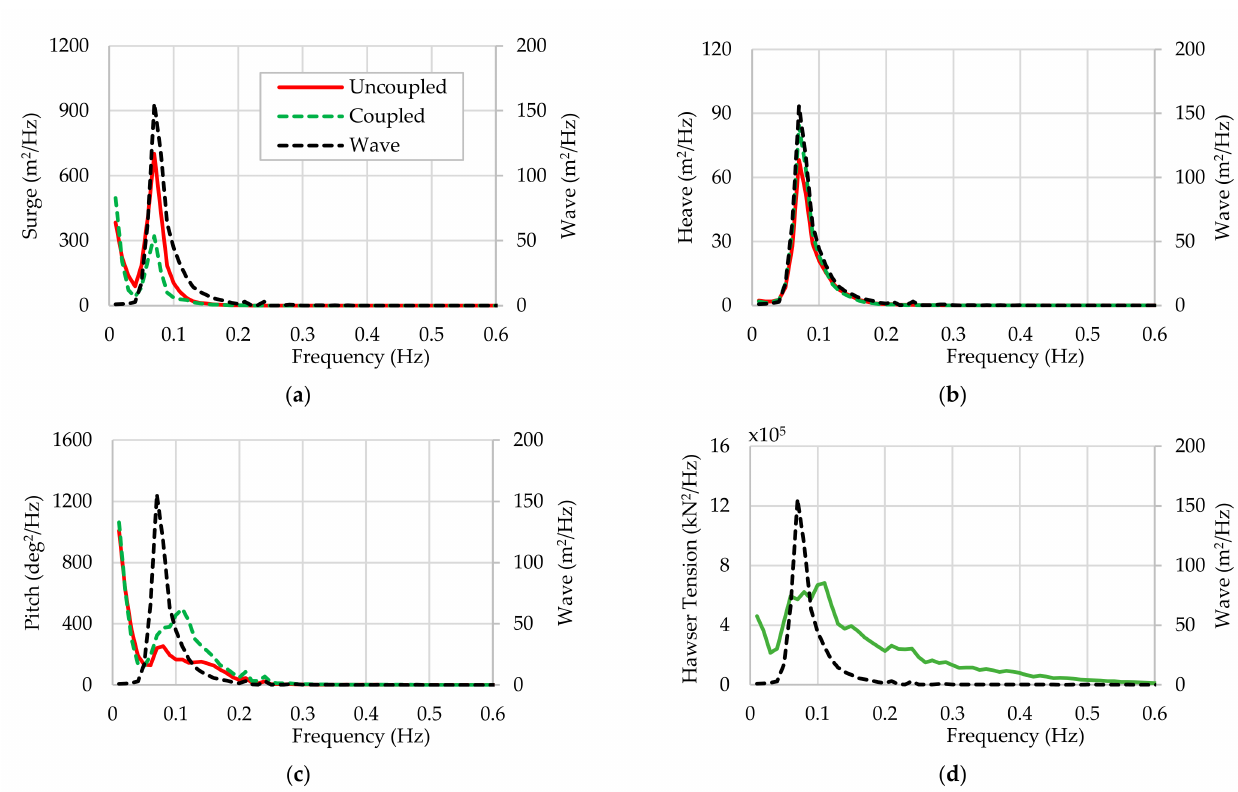
Figure 12. Spectral densities of mooring buoy motions and hawser tensions for 50 y, heading 0 deg.: ( a ) buoy surge; ( b ) buoy heave; ( c ) buoy pitch; ( d ) Hawser tensions for coupled